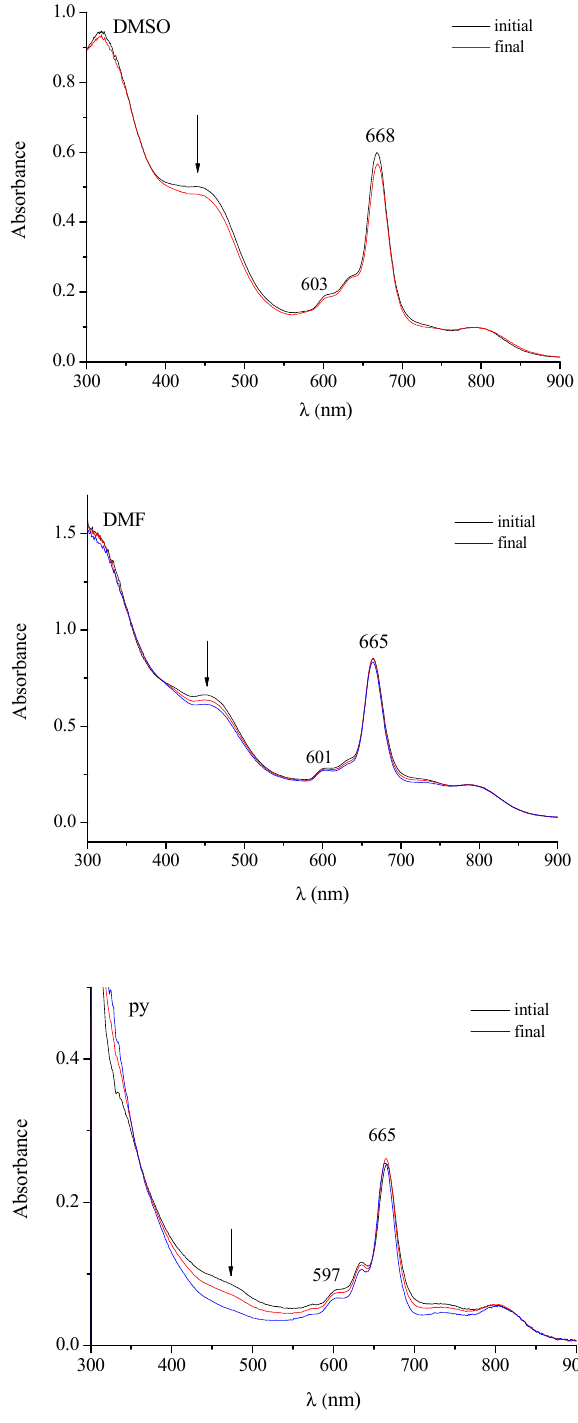
Figure 14. UV-visible spectra in the range 300–900 nm of the complex [{Pd(CBT 2 )} 4 Py 8 TPyzPzIn(OAc)]·19H 2 O in different solvents. The present highly hydrated CBT derivative has been observed via its UV-visible spectral behavior in DMSO and DMF (Figure 14, up and center) to remain practically unchanged during 24 h, some persistent aggregation being present as indicated by the absorption observed in the region above 750 nm. In pyridine solution (Figure 14, bottom), during the same time, progressive decreasing of the 400–500 nm absorption was observed,